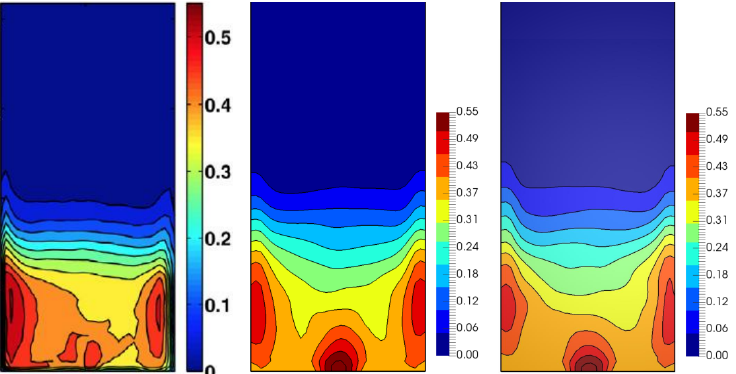
Figure A1. Time-averaged particle volume fraction. ( Left ): Experimental results, ( middle ): numerical results using Smagorinsky model, ( right ): numerical results without Smagorinsky